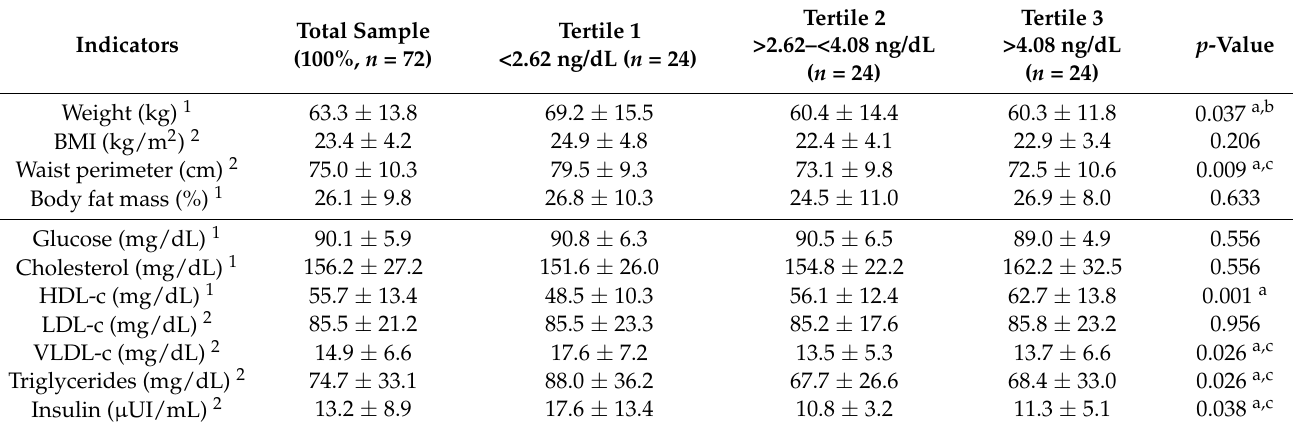
Table 5. Anthropometric and biochemical indicators with respect to adiponectin tertiles.